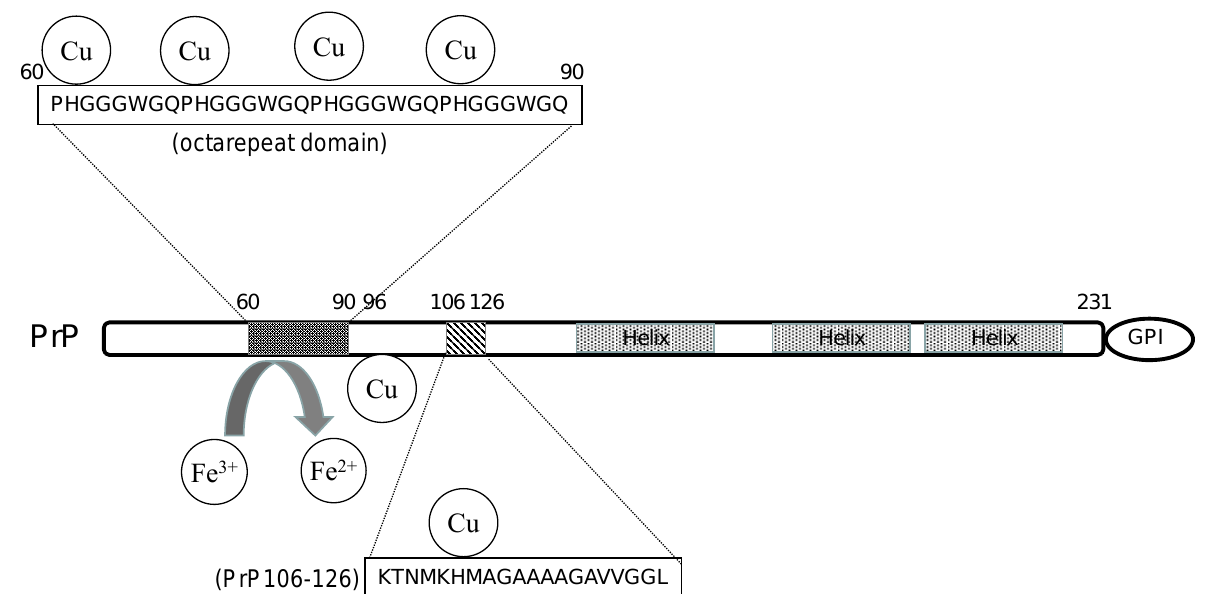
Figure 1. The structure and the metal-binding property of prion protein.